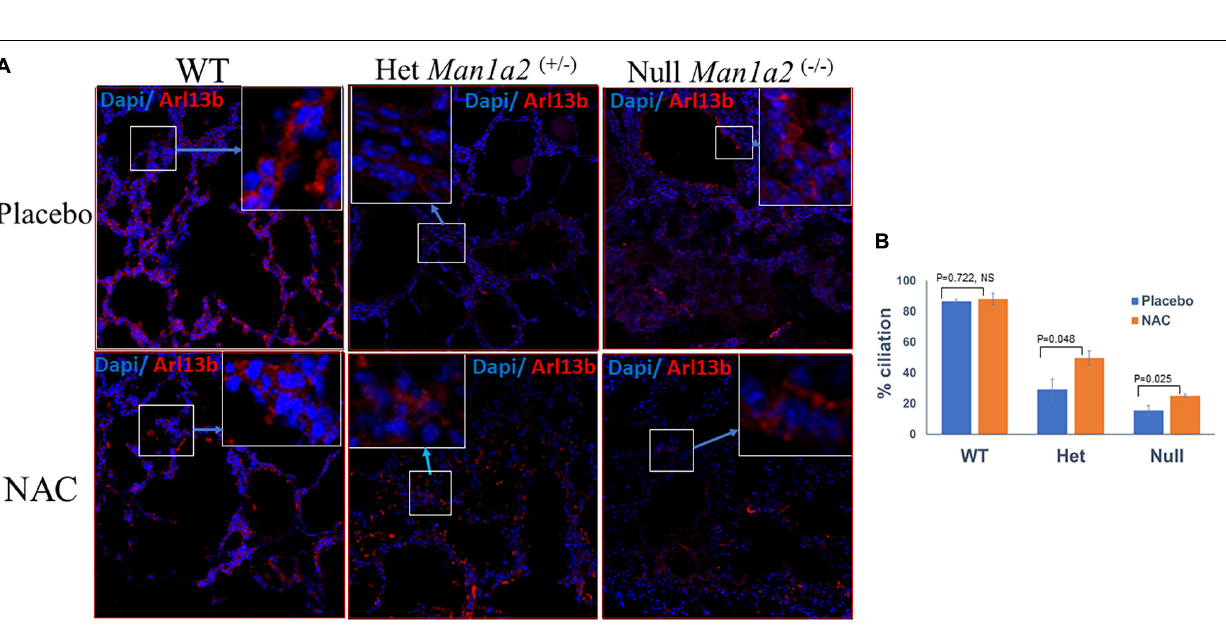
FIGURE 1 | Kaplan-Meier survival curves (A) and lung ciliation (B) in newborn pups by genotype, WT, heterozygous ( Man1a2 + / − ) and null ( Man1a2 − / − ). Effects of placebo and NAC exposure on survival in WT (C) and heterozygous (D) newborn pups, and null (E) dead pups. The percent ciliation was expressed as percentage of Arl13b + cells quantified using ImageJ software.